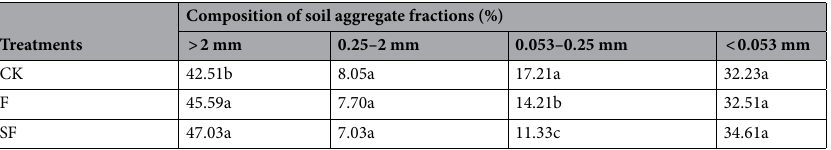
Table 1. Contents of soil aggregates in different treatments. Note within columns, means followed by the same letter are not significantly different according to LSD (0.05).